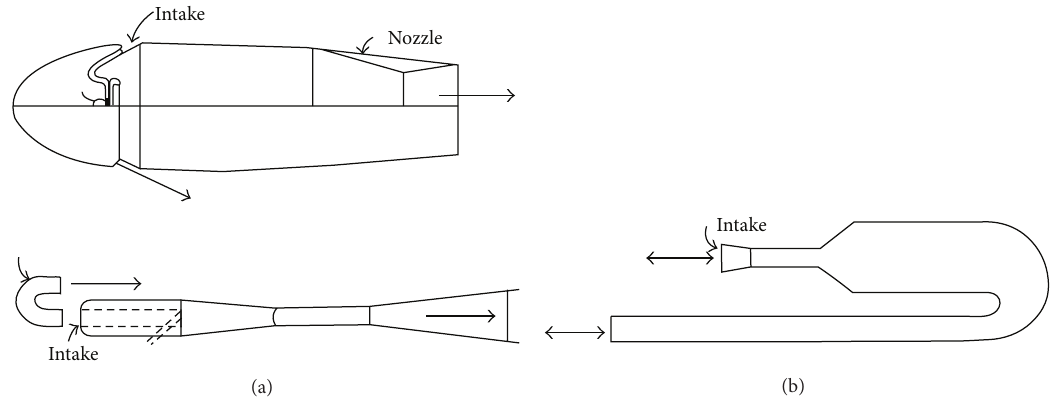
Figure 13: Non-PDE pulse jet designs and valveless pulsejet configurations [40].